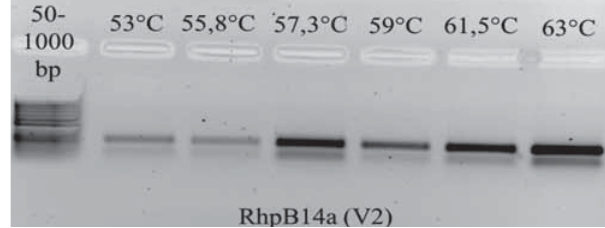
Figure 5. Gradient PCR of RhpB14a primer with V2 genomic DNA sample. First lane is 50 bp Gene Ruler (Fermentas, Biocenter, Hungary). The amplified fragments were at 250 bp with different annealing temperature of the Table 3. Result of the fragment length analysis DNA